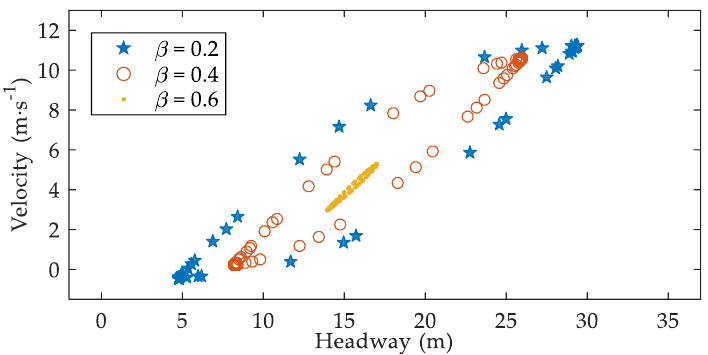
Figure 4. Snapshots of velocity against headway under different β when 8000 s t , where 0.2 α , 1.2 s T .